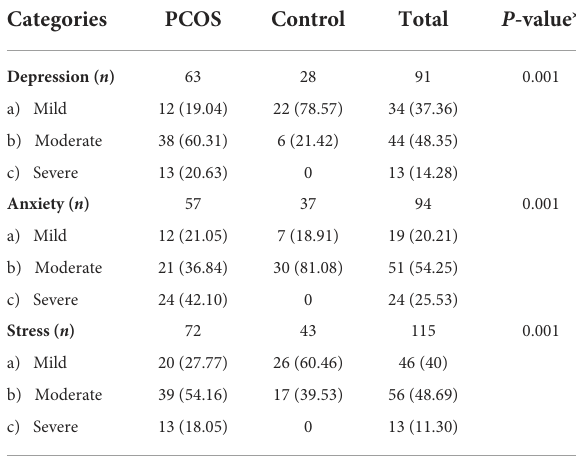
TABLE 3 Level of severity of depression, anxiety, and stress. TABLE 4 Logistic regression analysis of depression, anxiety, and